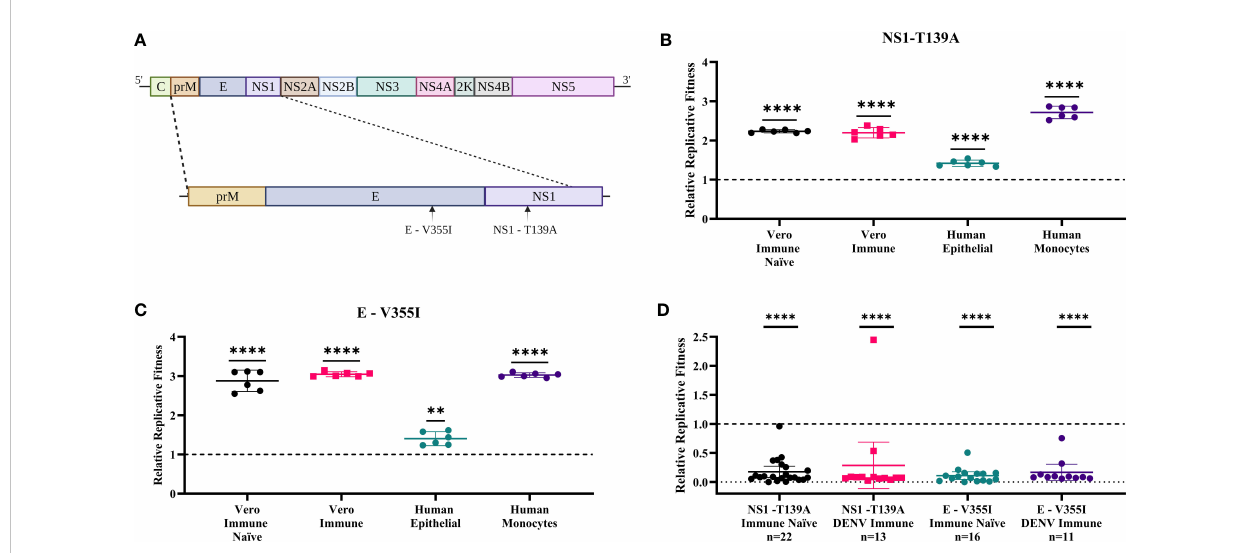
FIGURE 3 Zika virus (ZIKV) mutants have enhanced fi tness in mammalian cells and reduced fi tness in mosquitoes. (A) Two mutations were selected (E-V355I and NS1-T139A) to assess replicative fi tness. WT virus was mixed with each mutant virus at a 1:1 PFU ratio and used to infect cell lines (MOI=0.01) and mosquitoes (10 6 pfu/ml). Post-infection, virus was harvested and sequenced. The relative fi tness was calculated by comparing the proportion of the mutant virus before and after infection. (B, C) In vitro competition assays. B) NS1- T139A and C) E- V355I represent results on cell lines (t-test represented by **** p< .0001 and ** p = .0021). (D) Represent results in mosquitoes. Each data point represents the whole-body homogenate of a single mosquito, and the error bars represent the standard deviation from the mean of pooled fi tness across all mosquitoes (N represents the number of mosquitoes) from two independent experiments (Fisher ’ s exact test represented by **** p < .0001).